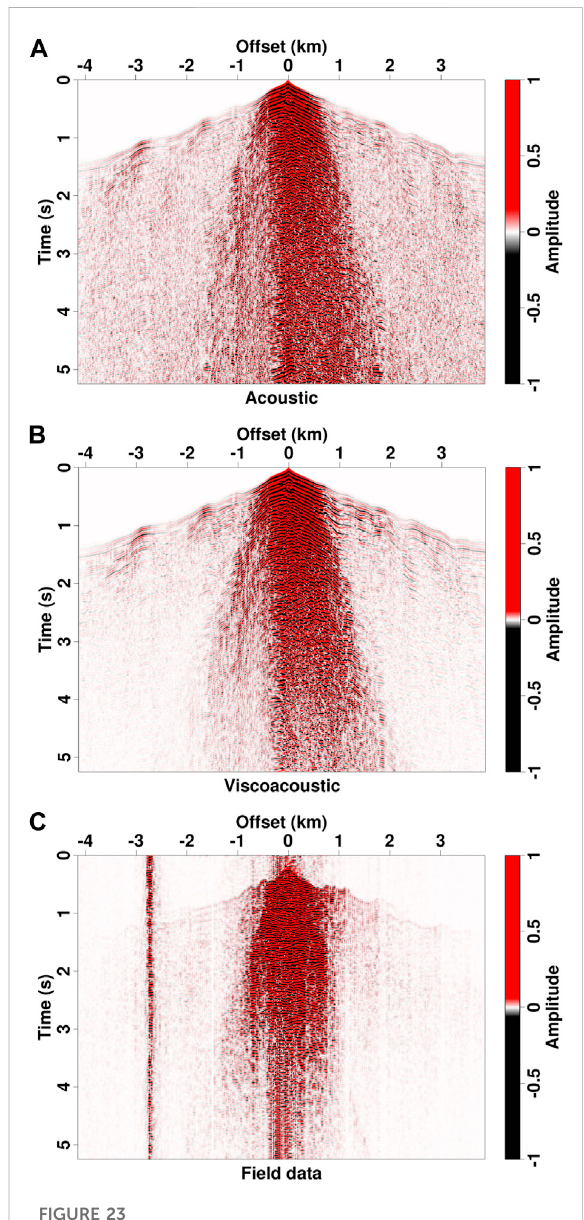
FIGURE 23 Comparison of synthetic common-shot gathers with fi eld data acquired from Chinese Loess Plateau. (A) 3D acoustic modeling result, (B) 3Dviscoacoustic modeling result,and (C) fi eld